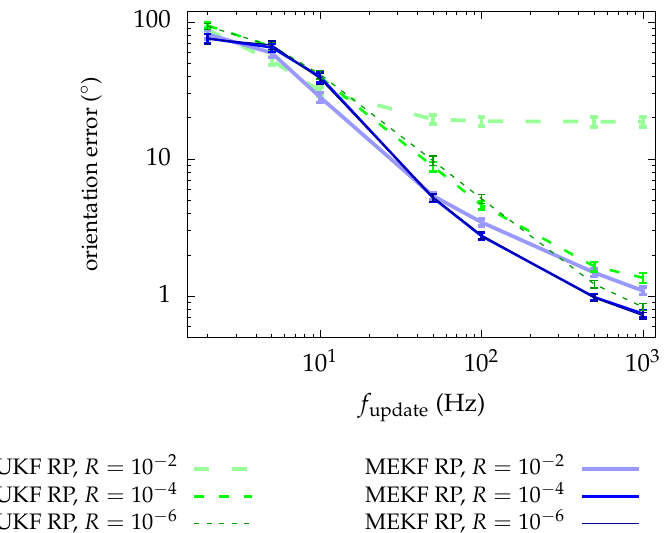
Figure 6. Mean of the performance metric for each MKF. Only results for the RP chart are plotted. Bars represent the confidence interval (3 σ ) in the mean